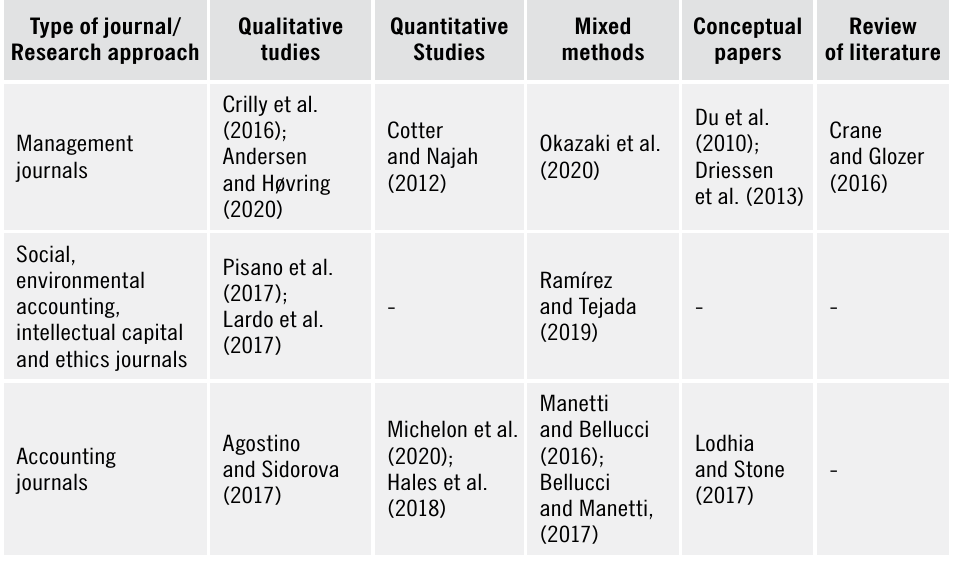
Table 5. Reviewed studies on the communication channels used to engage stakeholders, by journal type and research